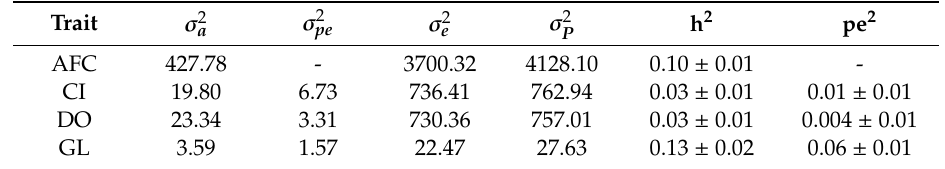
Table 3. Variance components and heritability estimates for reproductive traits of Hanwoo cattle using multi-trait